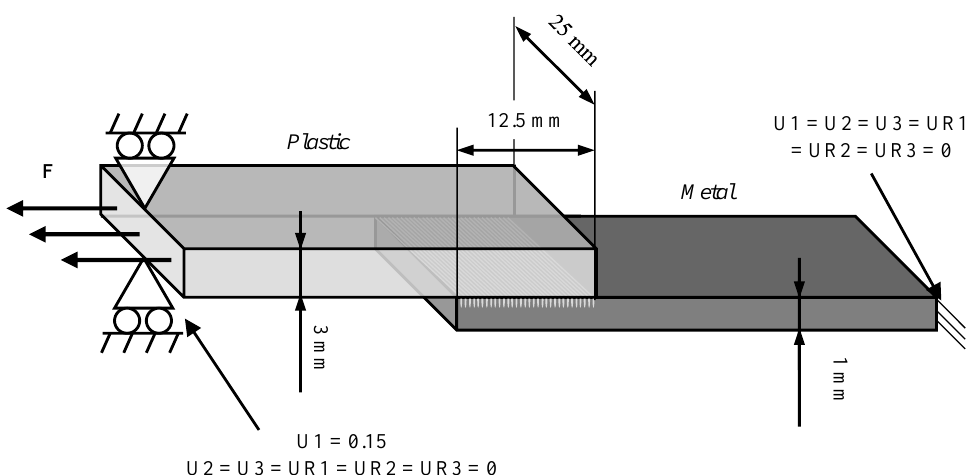
Figure 9. Dimensions and boundary conditions of the single-lap-joint specimen.